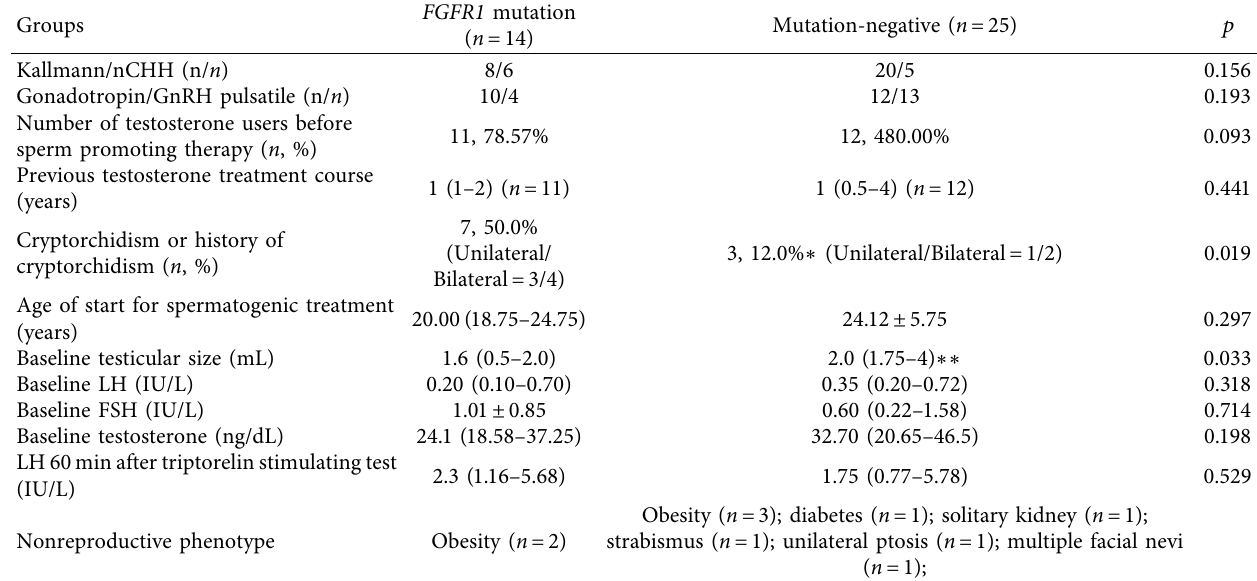
Table 2: Comparison of clinical characteristics between the FGFR1 gene group and the mutation-negative group at baseline.